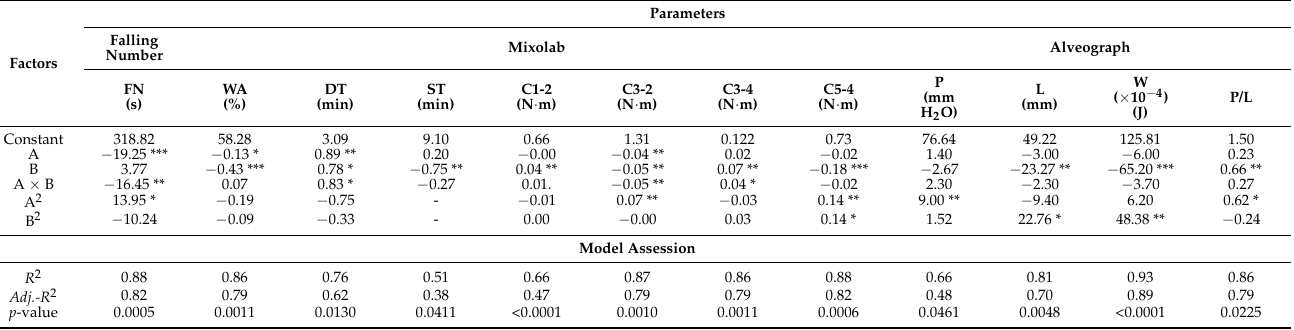
Table 2. ANOVA results of the models fitted for falling number and dough rheological properties determined using Mixolab and